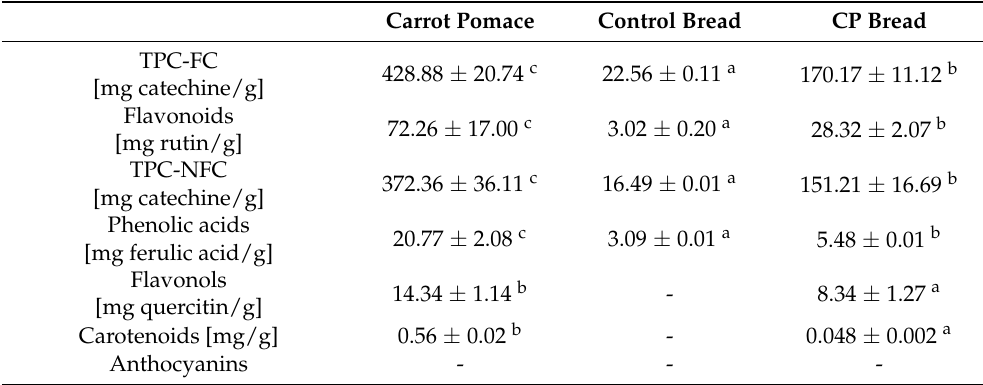
Table 4. Major groups of antioxidants in carrot pomace, control wheat bread and wheat bread enriched with 15% carrot pomace